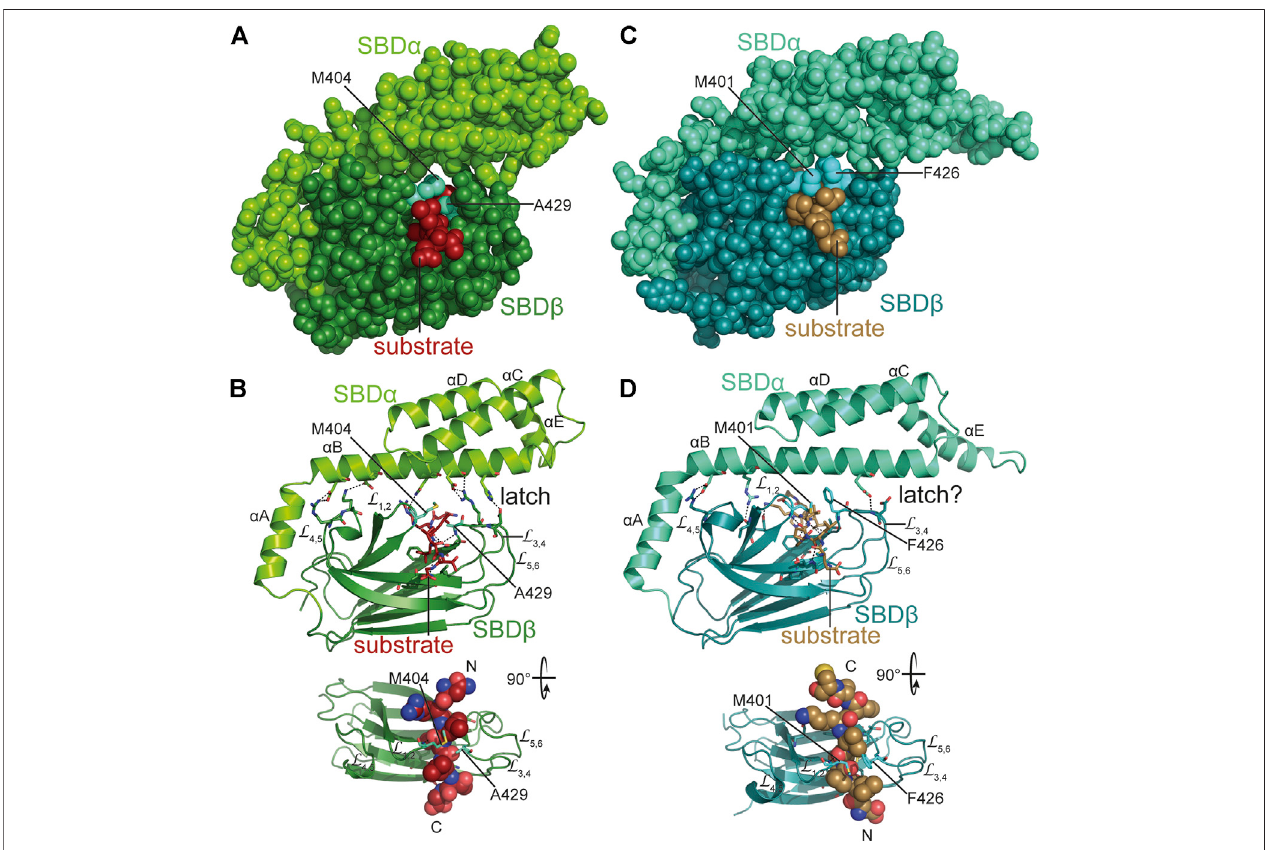
FIGURE 6 | Interaction of Hsp70s with peptide substrates. (A,B) , crystal structure of E. coli DnaK SBD in complex with a peptide substrate (NRLLLTG) in space- fi lling representation (A) and as cartoon (B) [1DKX, (Zhu et al., 1996)]. Polar contacts between SBD β and SBD α , as well as, between SBD β and substrate peptide are shown as black dashed lines. Arch forming residues M404 and A429 are labeled. Lower panel, SBD β rotated as indicated with substrate peptide in space- fi lling representation and N-and C-terminus of the bound peptide labeled with N and C. (C,D) , crystal structure of the SBD of E. coli HscA in complex with a peptide (ELPPVKIHC) comprising the interaction sequence in IscU [1U00, (Cupp-Vickery et al., 2004)] in space- fi lling (C) and cartoon (D) representation. Arch forming residues M401 and F426 are labeled. Whether the single hydrogen bond between SBD α and outer loops of SBD β functions as a latch is unclear. Lower panel, SBD β rotated as indicated with substrate peptide in space- fi lling representation and N-and C-terminus of the bound peptide labeled with N and C.